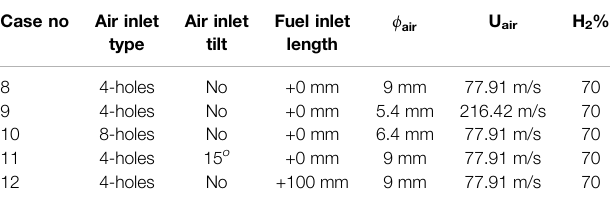
TABLE 2 | Summary of the operating conditions for the multi-hole air injector cases.